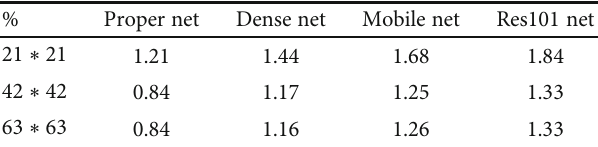
ff erent sizes of data Table 7: N l ARE of di